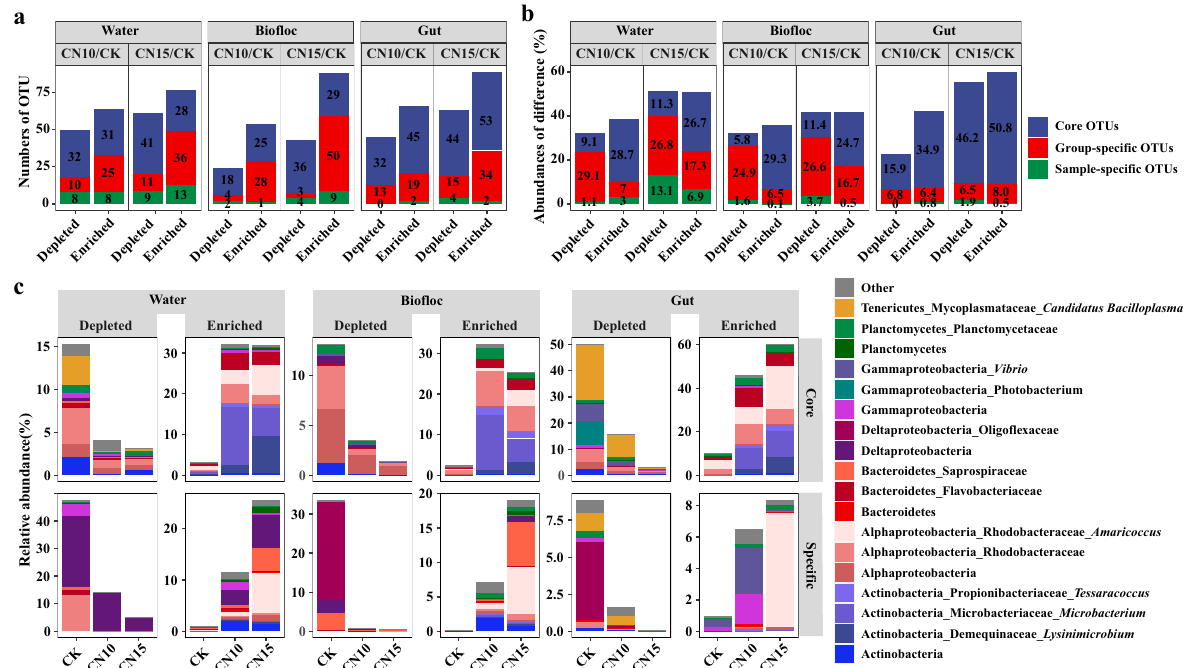
Fig. 3 The numbers and relative abundances of discriminatory OTUs in rearing water, bio fl oc, and gut samples between control and sucrose addition culture systems. a Number of signi fi cantly discriminatory OTUs ( P FDR < 0.05) detected in rearing water, bio fl oc, and gut samples between control and sucrose addition groups. b The cumulative abundances of signi fi cantly enriched and depleted OTUs in rearing water, bio fl oc, and gut samples between control and sucrose addition groups. c The relative abundances and compositions of signi fi cantly enriched and depleted OTUs in rearing water, bio fl oc, and gut samples between control and sucrose addition groups. CK: without sucrose addition; CN10: the C/N ratio of about 10:1 obtained by sucrose addition; CN15: the C/N ratio of about 15:1 obtained by sucrose addition. Each sample had six replicates ( n = 6), except the water samples ( n = 4) and bio fl oc samples ( n = 2) in control